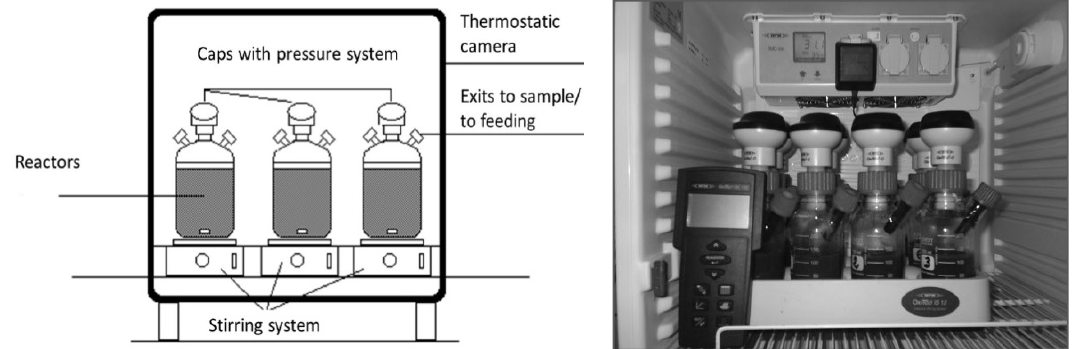
Figure 1. Scheme and picture of the system used in the activity tests.